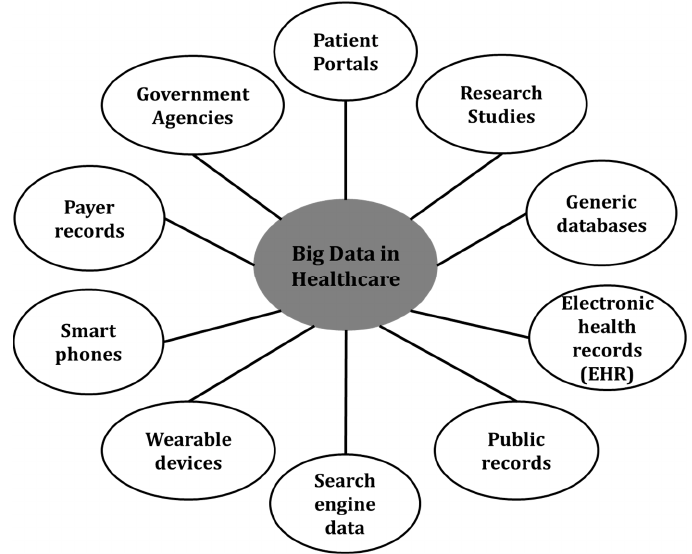
Figure 6. Big Data Applications. Table 3. Review of Big data in